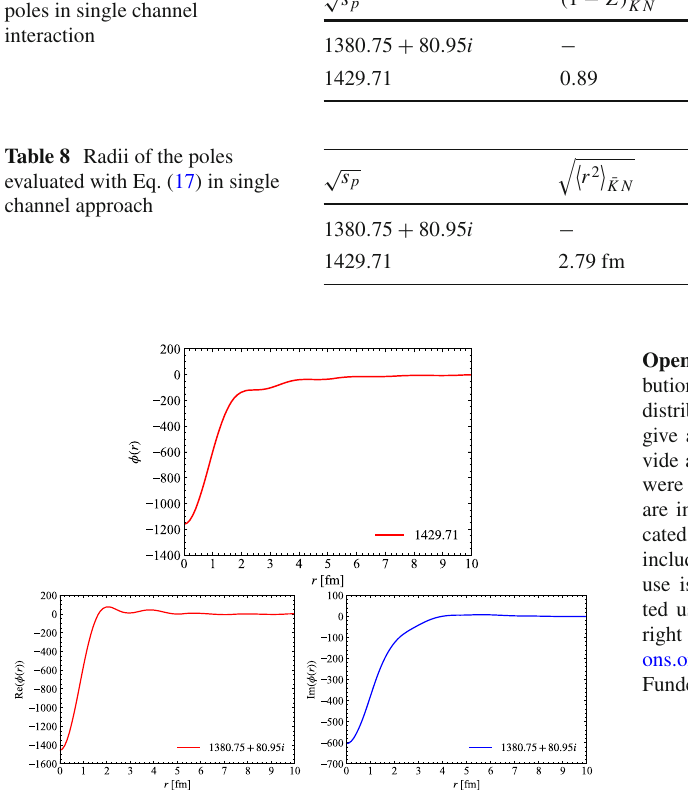
Fig. 10 Wave functions of the poles of ¯ K N (upper) and π(cid:4) (lower) in single channel